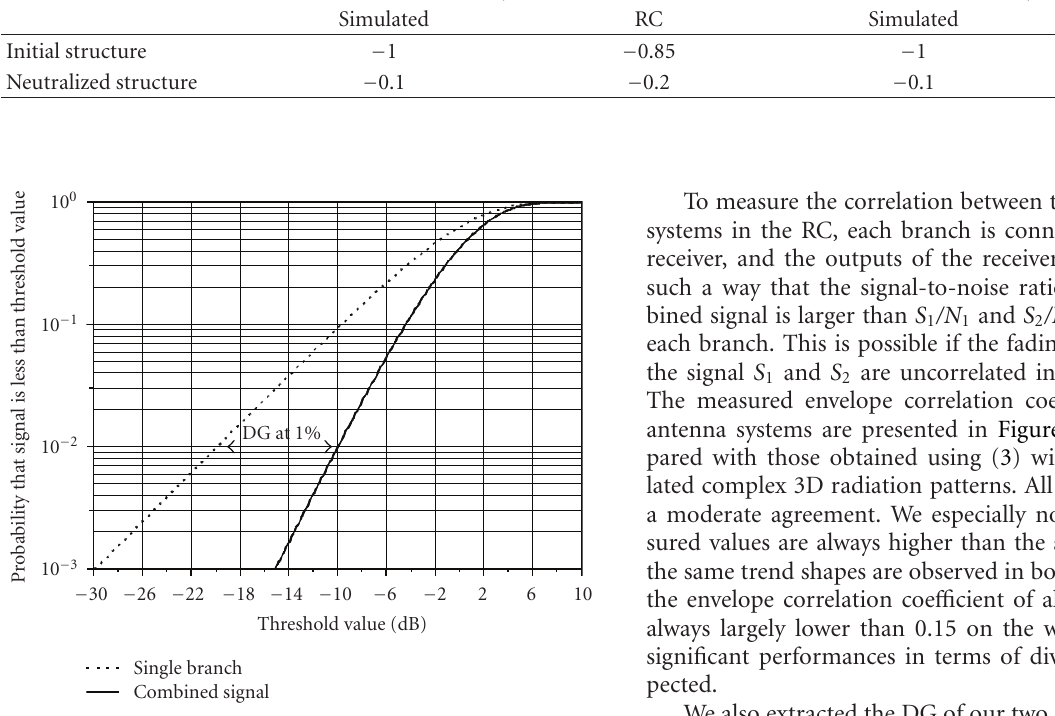
Figure 5: Simulated DG of the neutralized antenna-system in a uni- form